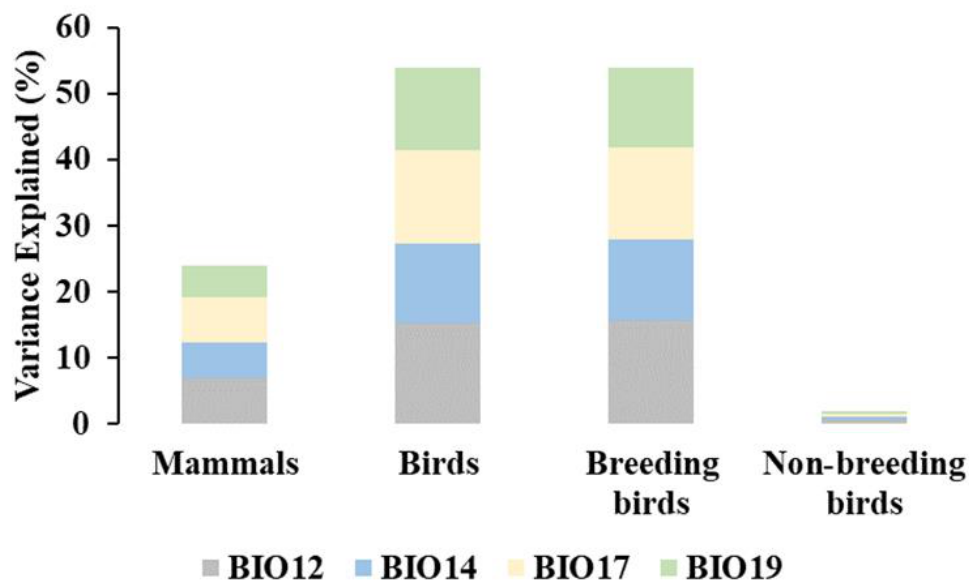
model for birds mainly justified the species richness variation among the four taxa (Figure 9). Figure 7. The relative importance of the four Bioclim variables and the four main taxa.